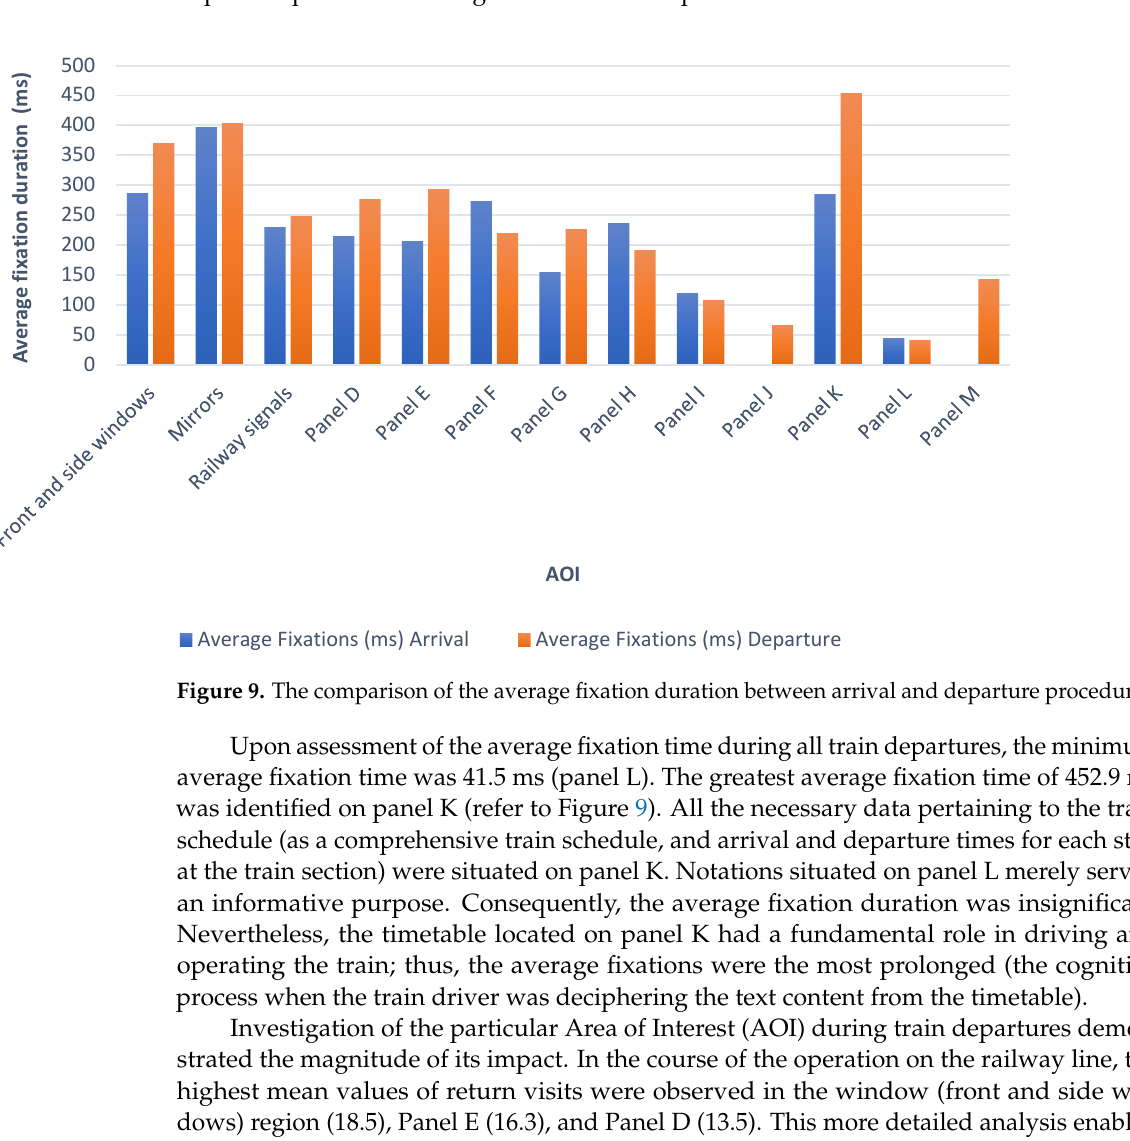
Figure 8. The comparison of the average dwell time between arrival and departure procedures.